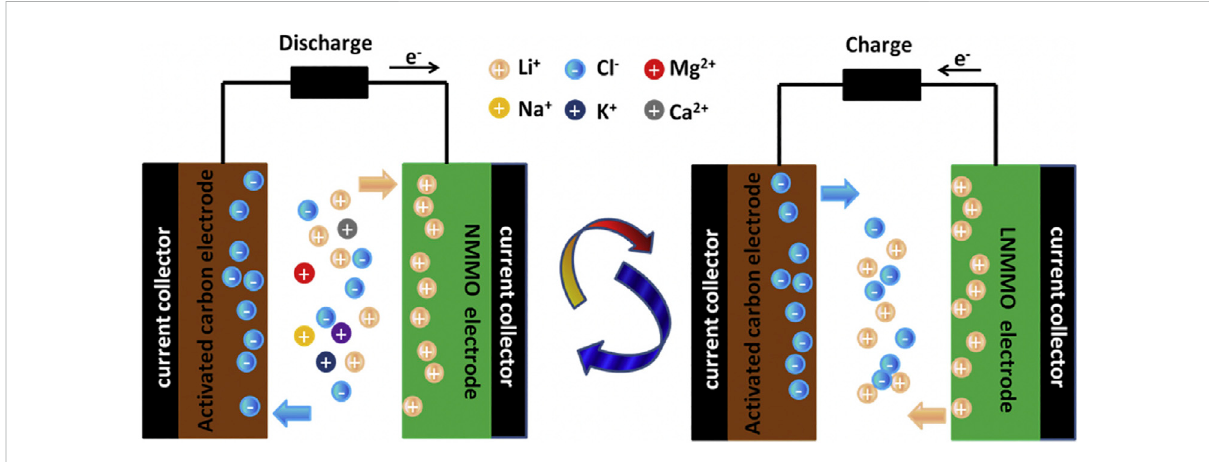
FIGURE 5 Illustration of electrochemical reaction process of NMMO/AC hybrid supercapacitor during charge and discharge (Zhao et al., 2020).